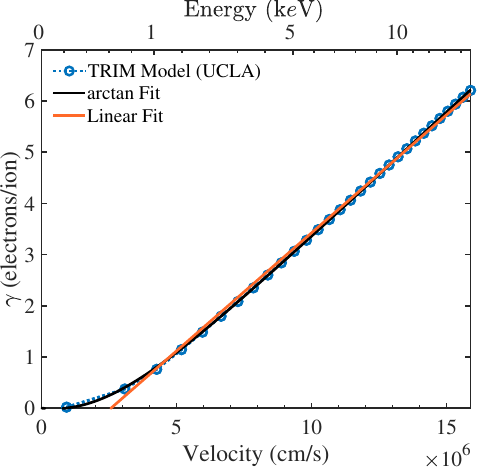
Figure 9. Average electron yield equations as a function of velocity for EMI + ions hitting stainless steel from 0.05–15 keV based on results from the TRIM model. The arc-tangent and linear fits are taken from Equations (8) and (9),